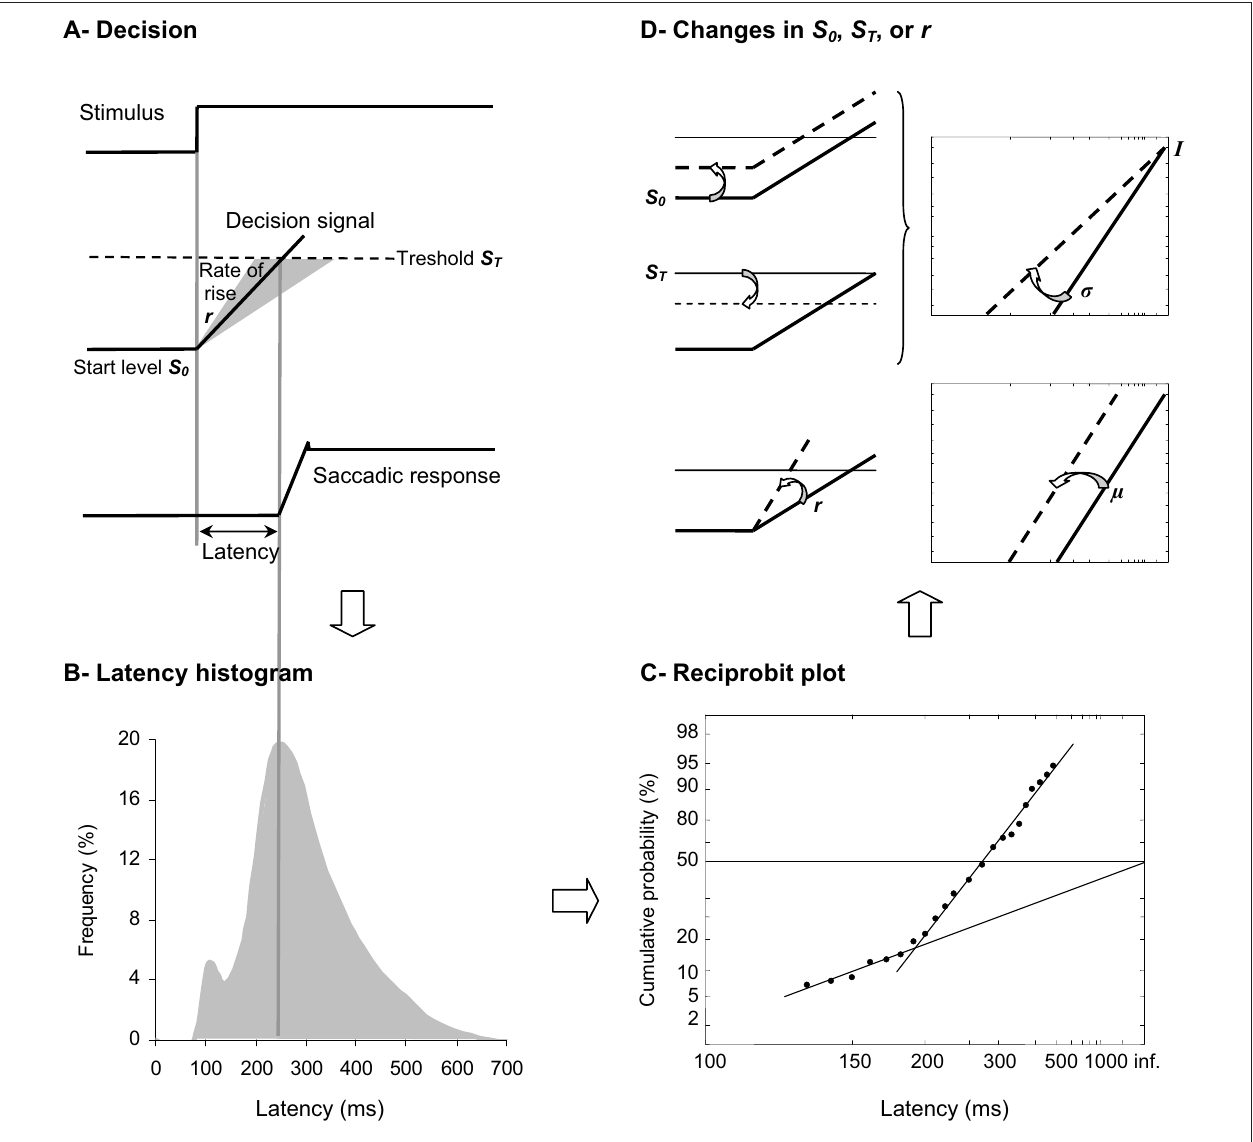
FIGURE 1 | (A) LATER model . From bottom to the top, we show the saccade position signal, the theoretical decision signal in a LATER unit, and the stimulus signal. In response to the Stimulus, the Decision signal initiates at the Start level S 0 , increases at a Rate of rise r , until it reaches the Threshold S T at which the Saccadic response begins. (B) Traditional histogram of Frequency (in %) as a function of Latency (in ms). The main distribution is skewed with a tail to the right and some population of express saccades can exhibit a distinct peak. (C) Resulting reciprobit plot of Cumulative probability on a probit scale (in %) as a function of Latency on a reciprocal scale (in ms). The main recinormal distribution lies on a straight line described by µ and σ . Early saccades can occur lying on a second line described by σ ’. (D) Changes that can occur in LATER. A change in the distance between S 0 and S T results in a swivel of the recinormal distribution around the intercept (up). A change in the rate of rise r results in a lateral shift of the recinormal distribution (down).